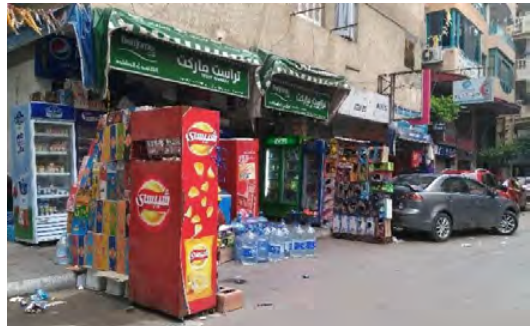
Figure 1. Infringement of shops on the street and sidewalk (The researcher, 2017)